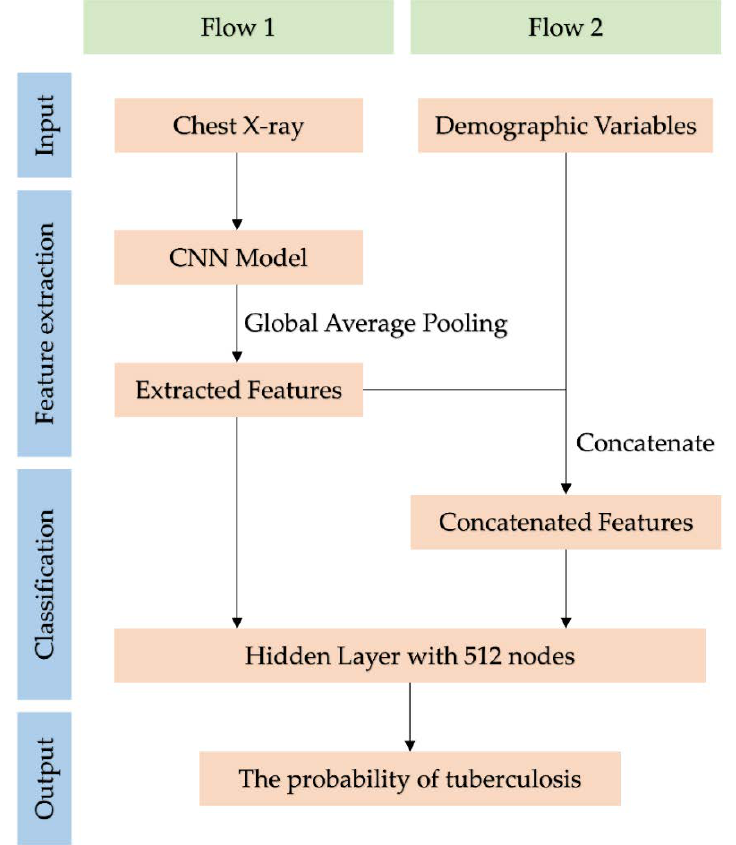
Figure 2. Flowchart of tuberculosis classification using the convolutional neural network (CNN) model. Flow 1 uses only chest X-rays for tuberculosis classification. Flow 2 uses demographic variables as well as chest X-rays.